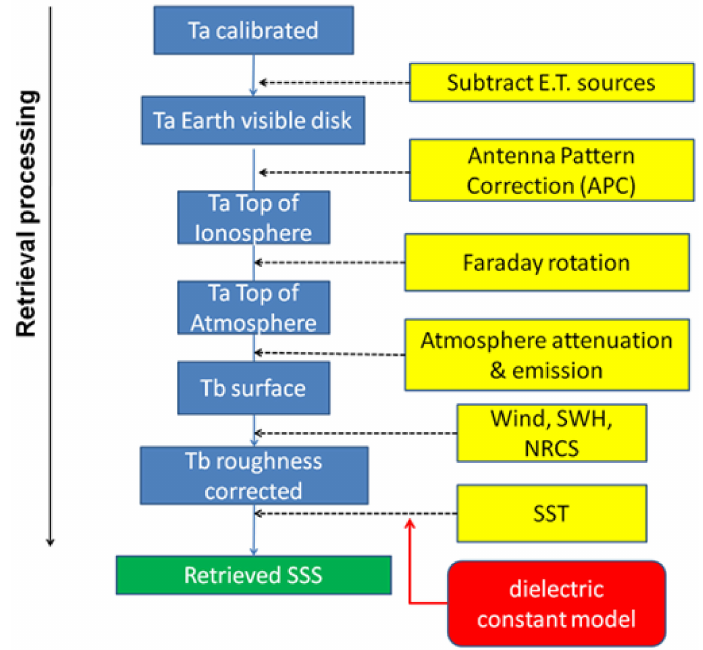
Figure 5. Flow diagram illustrating the steps in the Aquarius salinity retrieval algorithm. The process starts at the top with calibrated antenna temperature, TA, from the radiometer and ends with a measurement of SSS at the